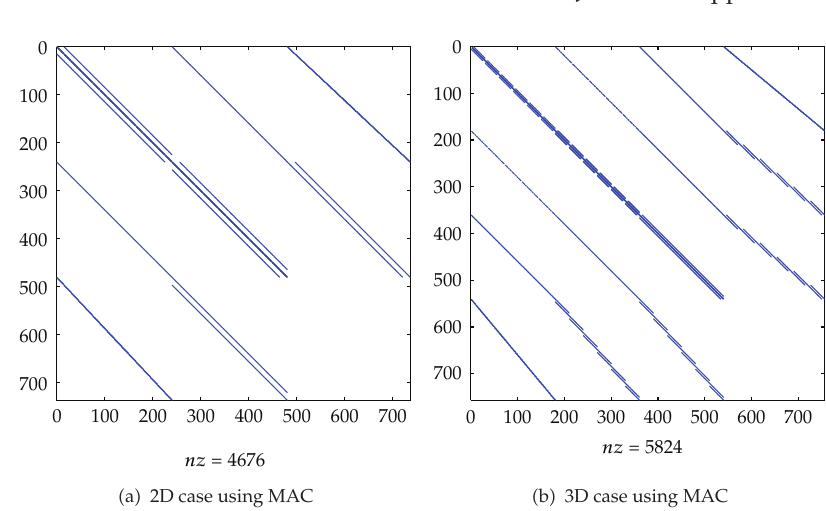
Figure 1: Sparsity patterns for di ff erent types of the Oseen problem in rotation